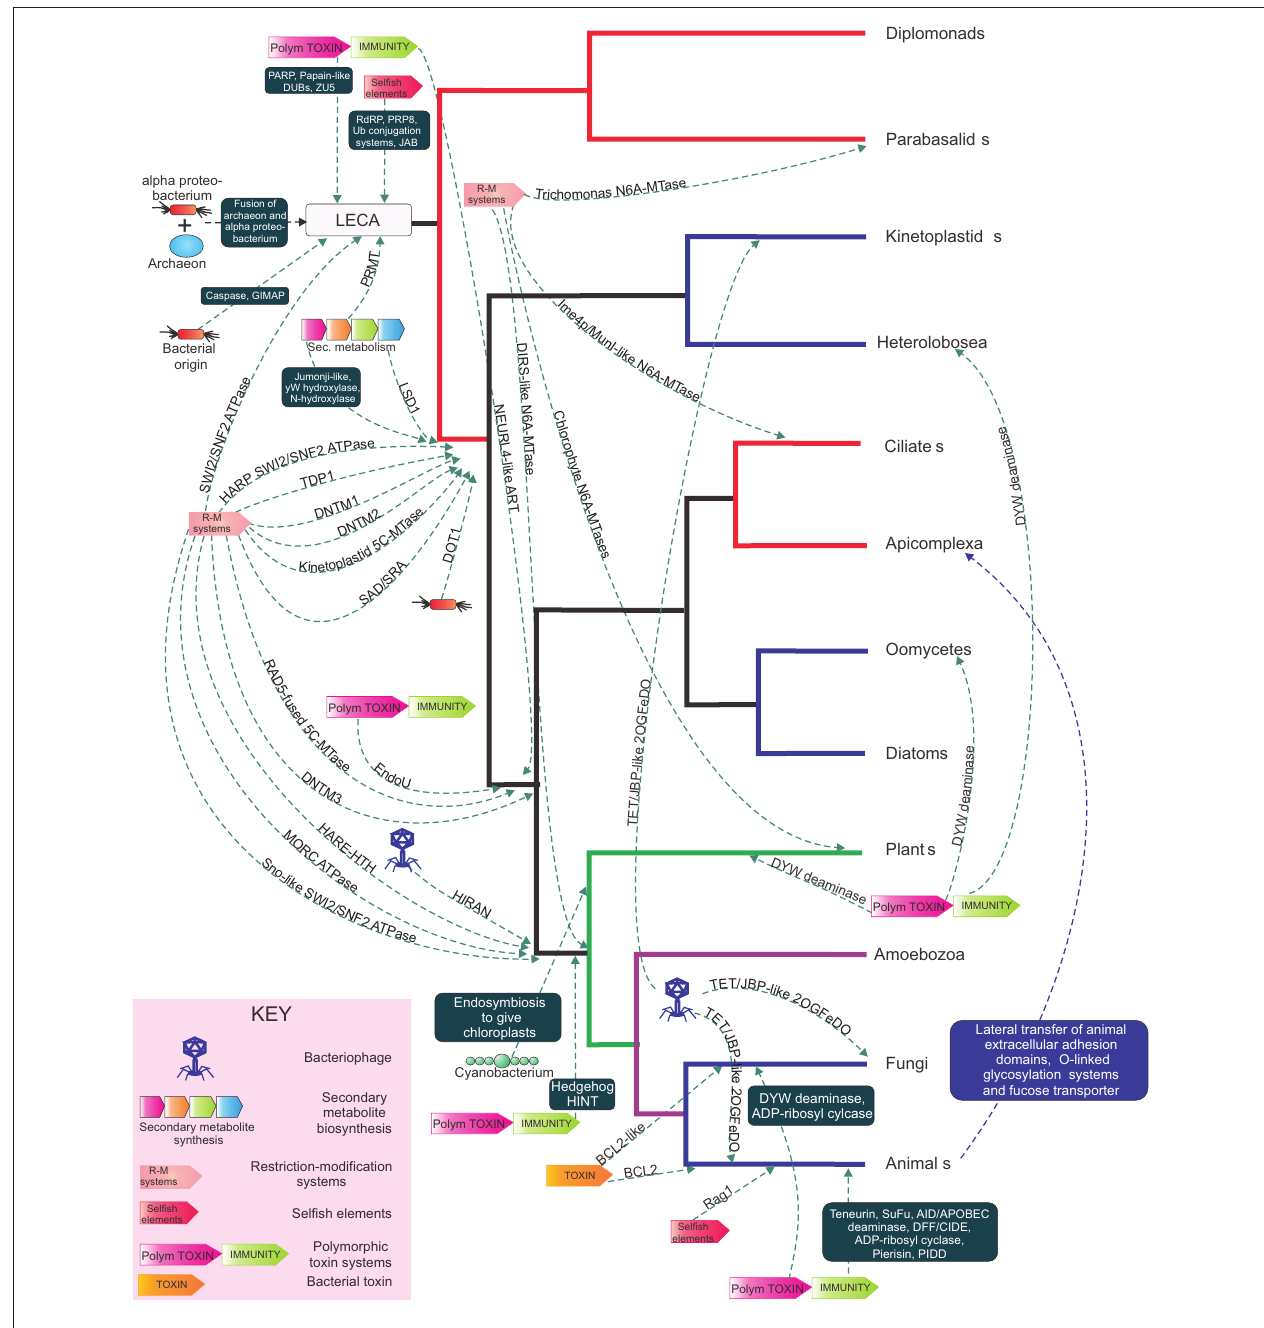
FIGURE 4 | A tree of the eukaryotic relationships illustrating the points of recruitment in eukaryotes in different functional systems of various domains from different biological conflict systems. With a eukaryotic tree as reference, the source and reconstructed point of transfer of various domains recruited from different conflict systems and symbiogenic events